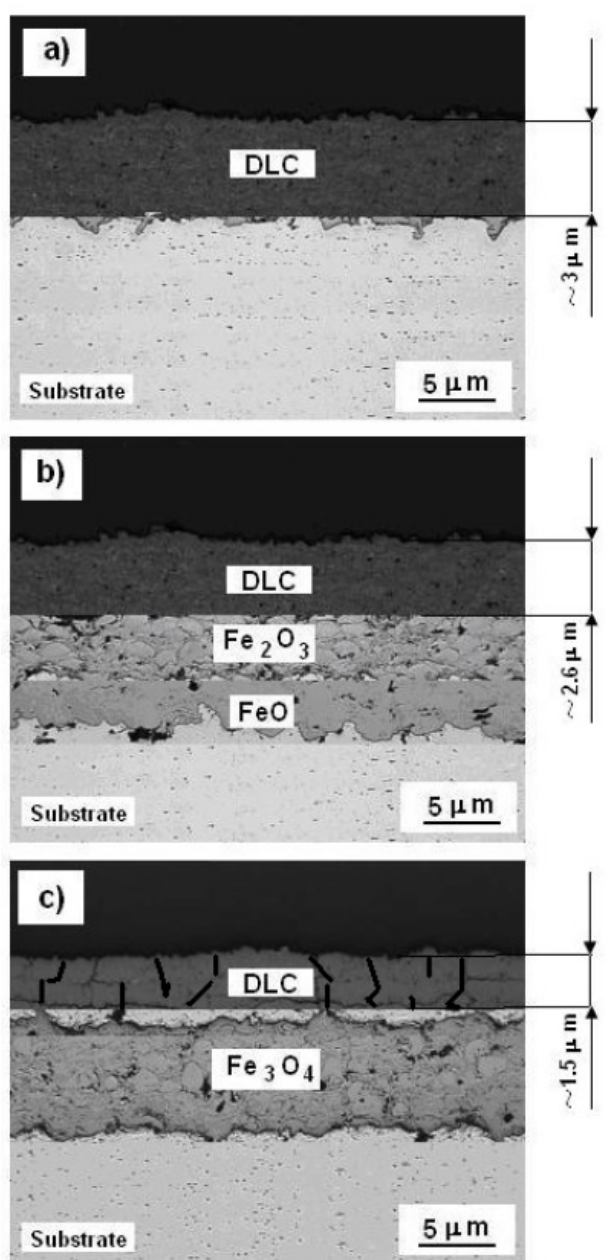
Figure 8. SEM of a cross-section of the S355 steel, with DLC coating, before and after heat treatment in air atmosphere, at temperatures: ( a ) room-temperature, ( b ) 400, and ( c ) 800 ◦ C. The exposure time was about 24